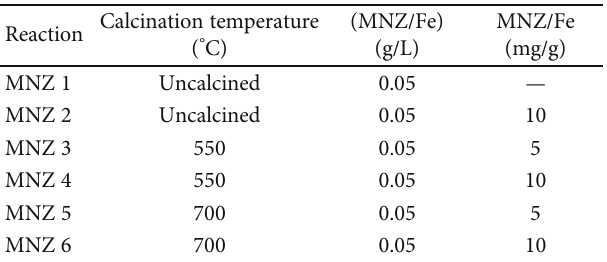
Table 5: Catalytic evaluation conditions of MNZ impregnated with FeCl . 3